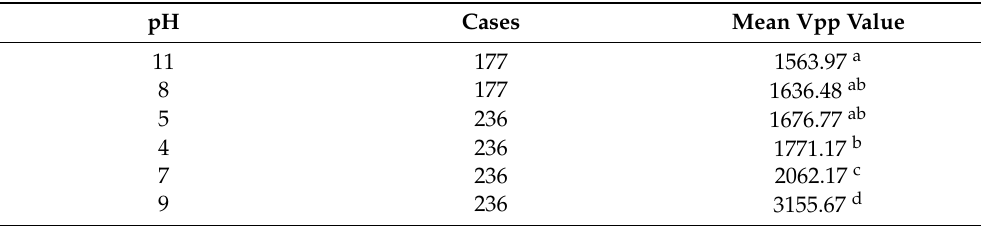
Table 5. Duncan’s Multiple Range Test for pH of Two-Way ANOVA results for Vpp with all gathered data.